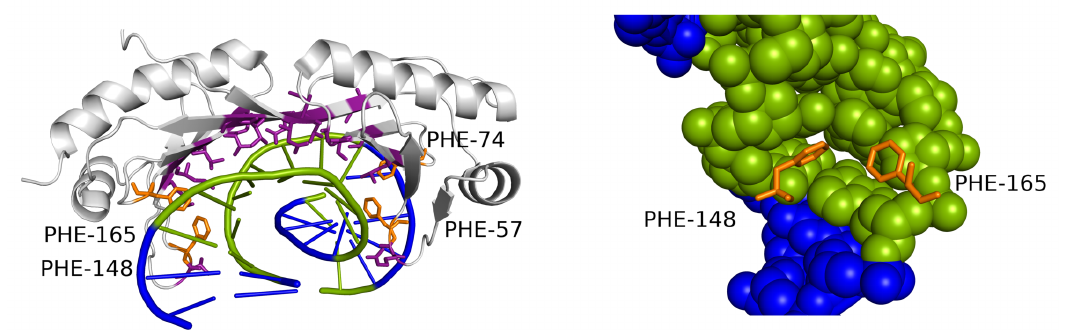
Figure 6. TBP DNA-binding motif interacting with the extremely widened minor groove. The contacted DNA sequence consists only of AT base pairs (green). Two phenylalanine residues (orange) intercalate into the helix on one or both edges of the motif (detail on the right). A similar DNA-contacting motif appears in the dataset also in 4ROC and 1YTB structures, both containing similar extreme deformations of the minor groove in AT-rich